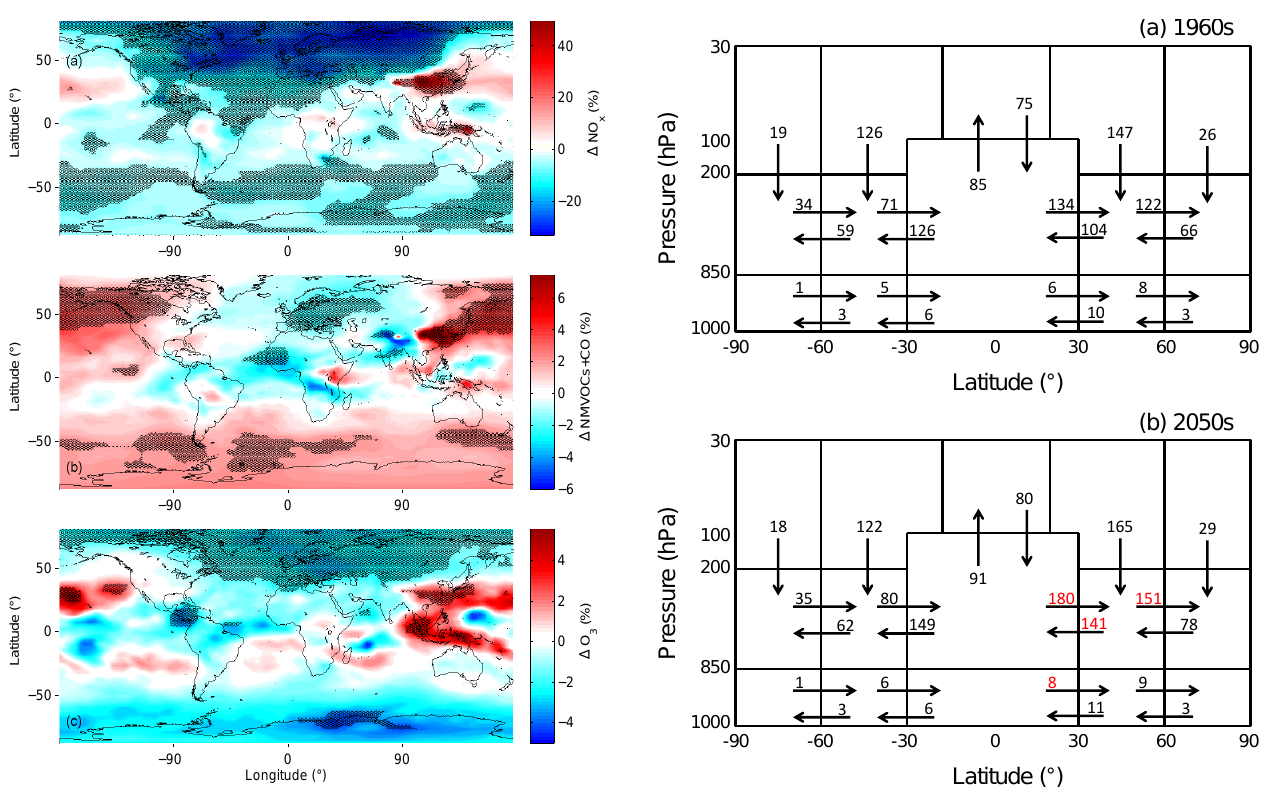
Figure 7. Decadal-mean ozone fluxes (Tgyear − 1 ) between defined tracer regions for (a) the 1960s and (b) the 2050s in the REF-C2 simulation. Red text in panel (b) indicates an increase of more than 20% from the same quantity in (a)